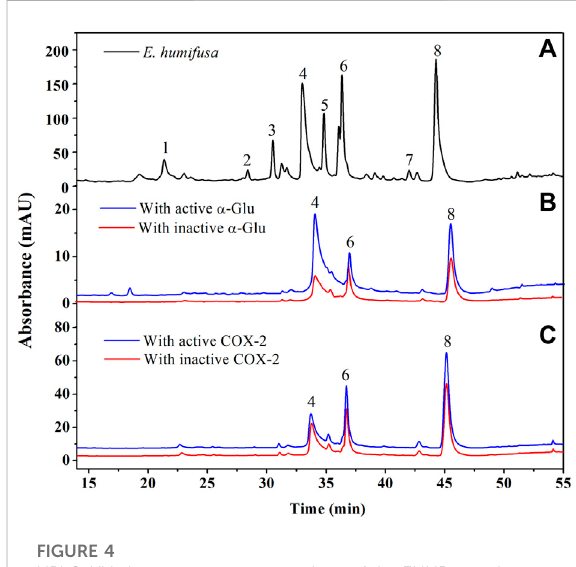
FIGURE 4 UPLC-UV chromatograms comparison of the EHNB sample (black) EHNB incubated with active enzyme (blue), and inactive enzyme (red) obtained at 360 nm. (A) Represents the chromatogram obtained from EHNB sample, (B) from α -Glu target and (C) from COX-2